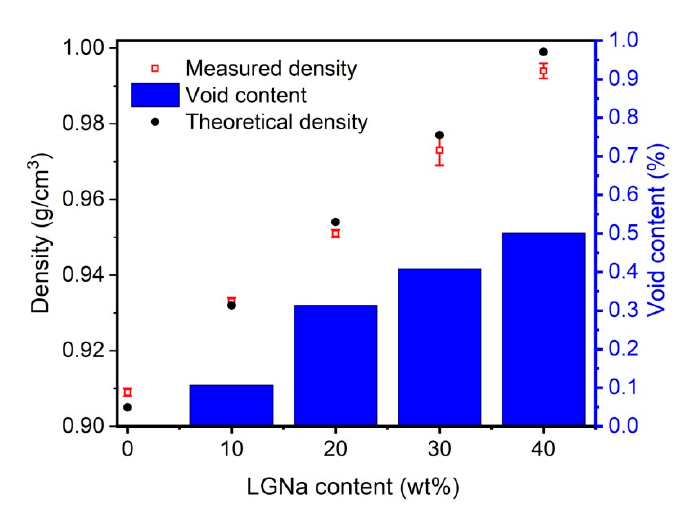
Figure 2. Theoretical and measured density of PP and blends of PP/LGNa showing the void content of all the blends studied.